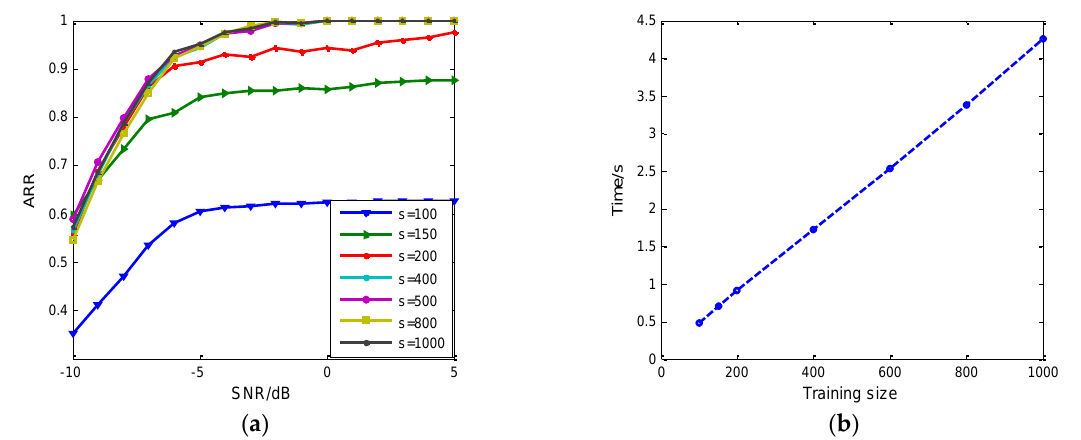
Figure 13. The effect of training size on RDBN performance. ( a ) The increase of training samples improves ARR within limits; ( b ) The training consuming time and sample size are linearly related.